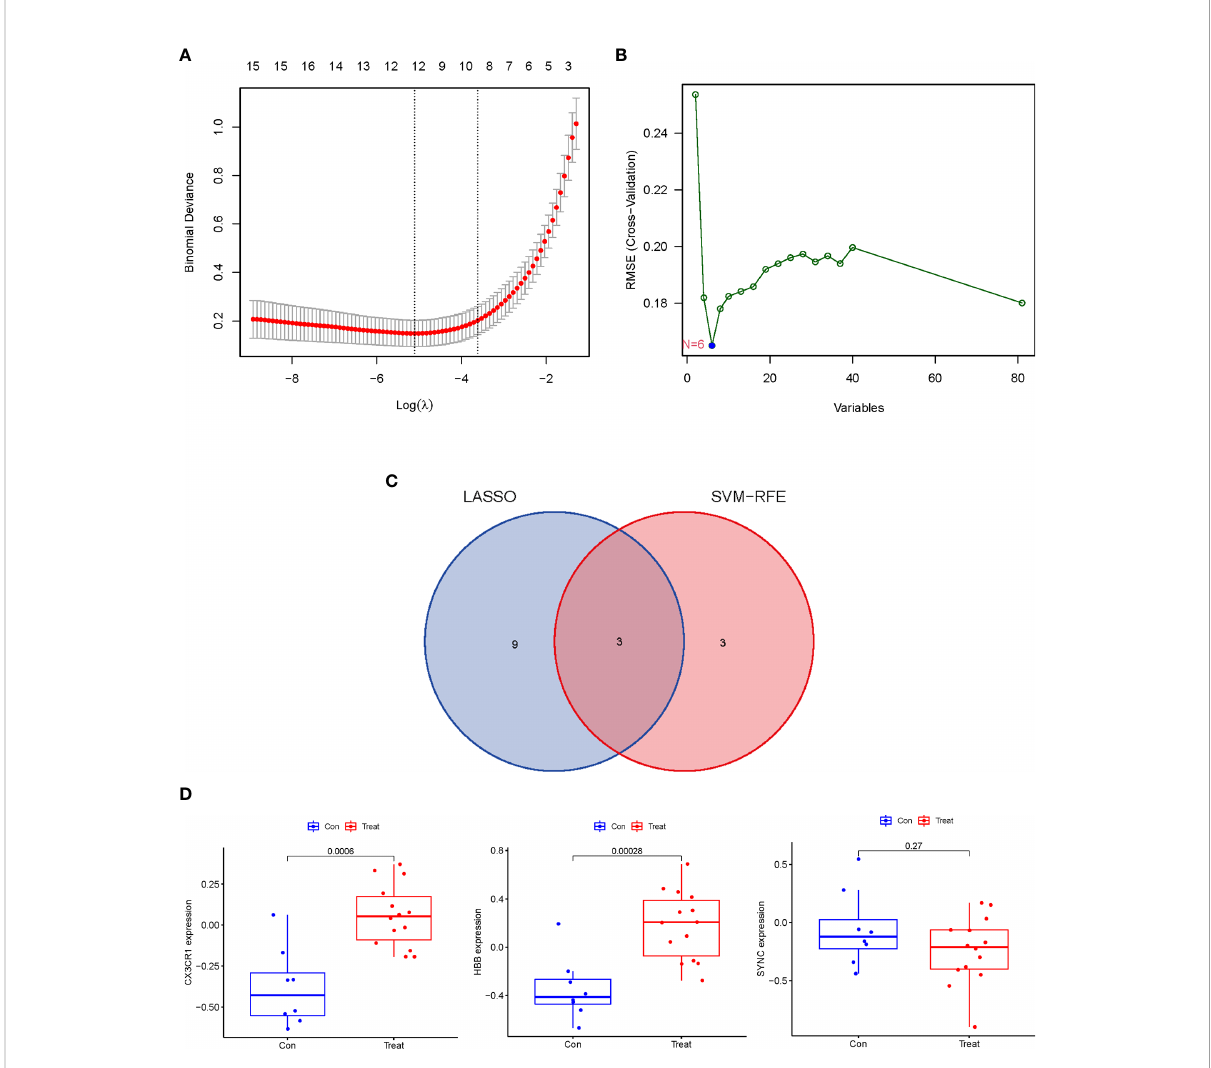
FIGURE 4 Identi fi cation and Veri fi cation of the discriminating power of potential biomarkers in AA. (A) Tuning feature selection in the “ LASSO ” model. The DEGs evaluated by 10-fold cross-validation in the “ LASSO ” regression model yielded 12 potential biomarkers. (B) The biomarkers screened by the SVM-RFE algorithm yielded 6 potential biomarkers. (C) Venn plot of potential biomarkers identi fi ed by “ LASSO ” and “ SVM-RFE ” algorithms. (D) The discrimination power of 3 potential biomarkers was veri fi ed in the validation dataset